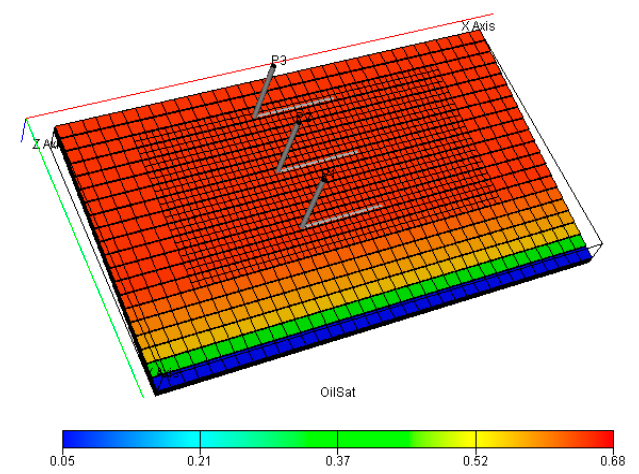
Figure 3. Initial oil saturation distribution in model II.